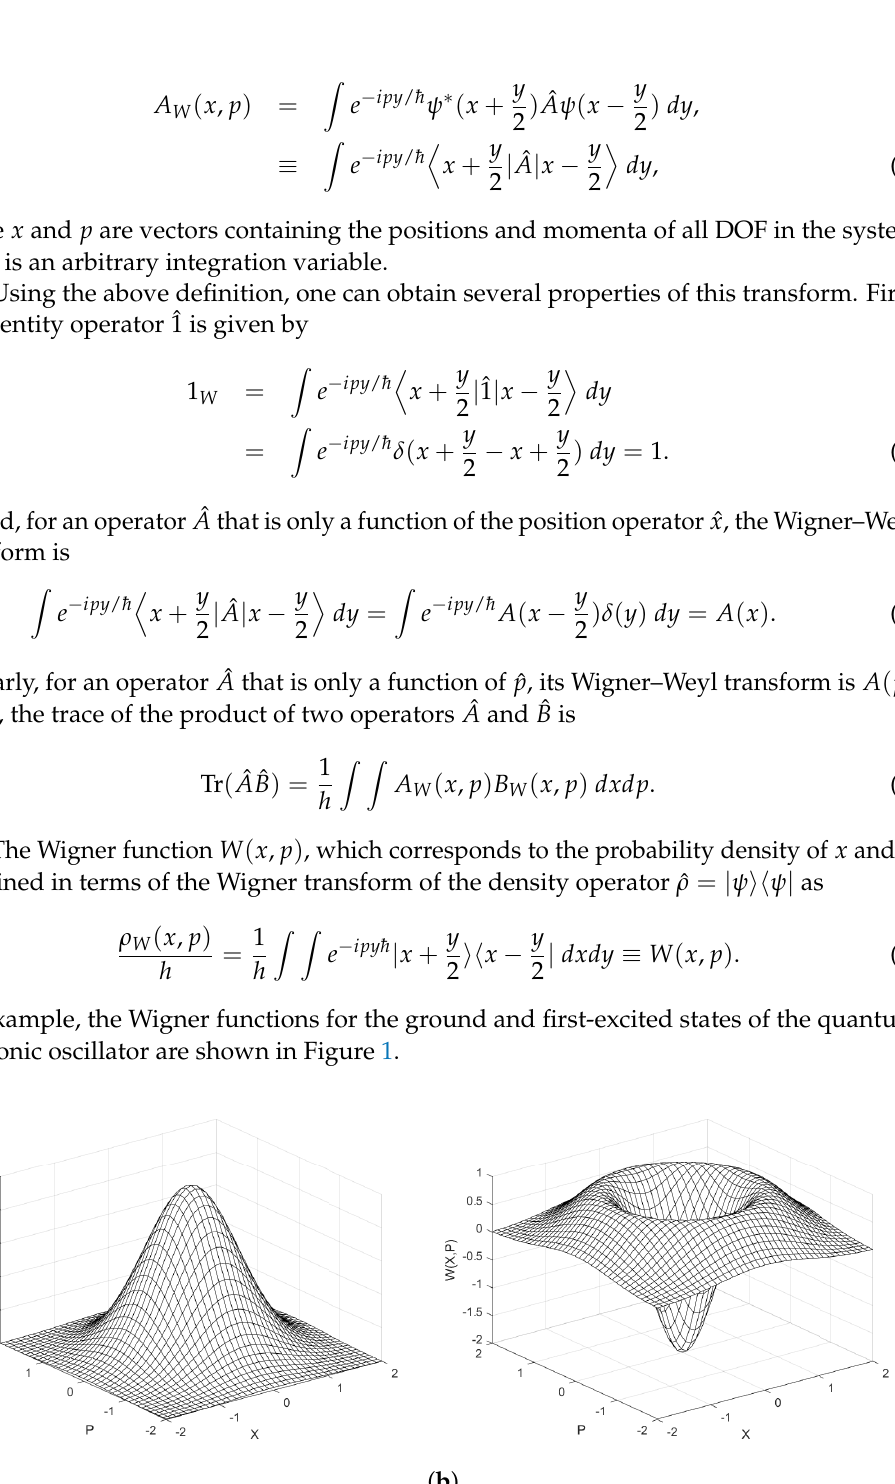
d 2 + 1 x 2 . The expressions for the Wigner functions are taken 2 2 dx 2